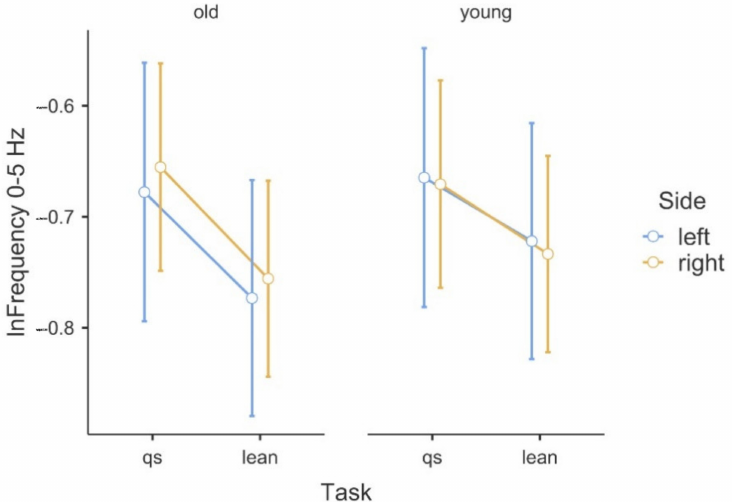
Figure 1. Illustration of the asymmetry of the logarithmic delta band frequency data in the (qs/lean) tasks in the comparison of the two